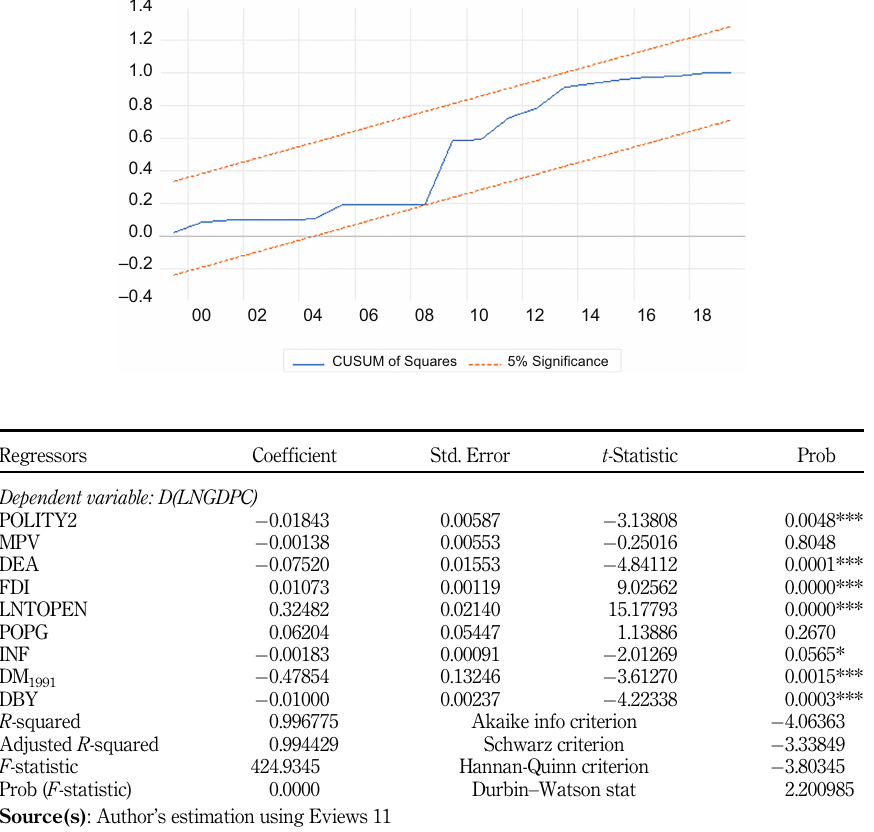
Table 6. Estimated long run coefficients for selected ARDL (1, 1, 0, 1, 1, 1, 0, 1, 0)